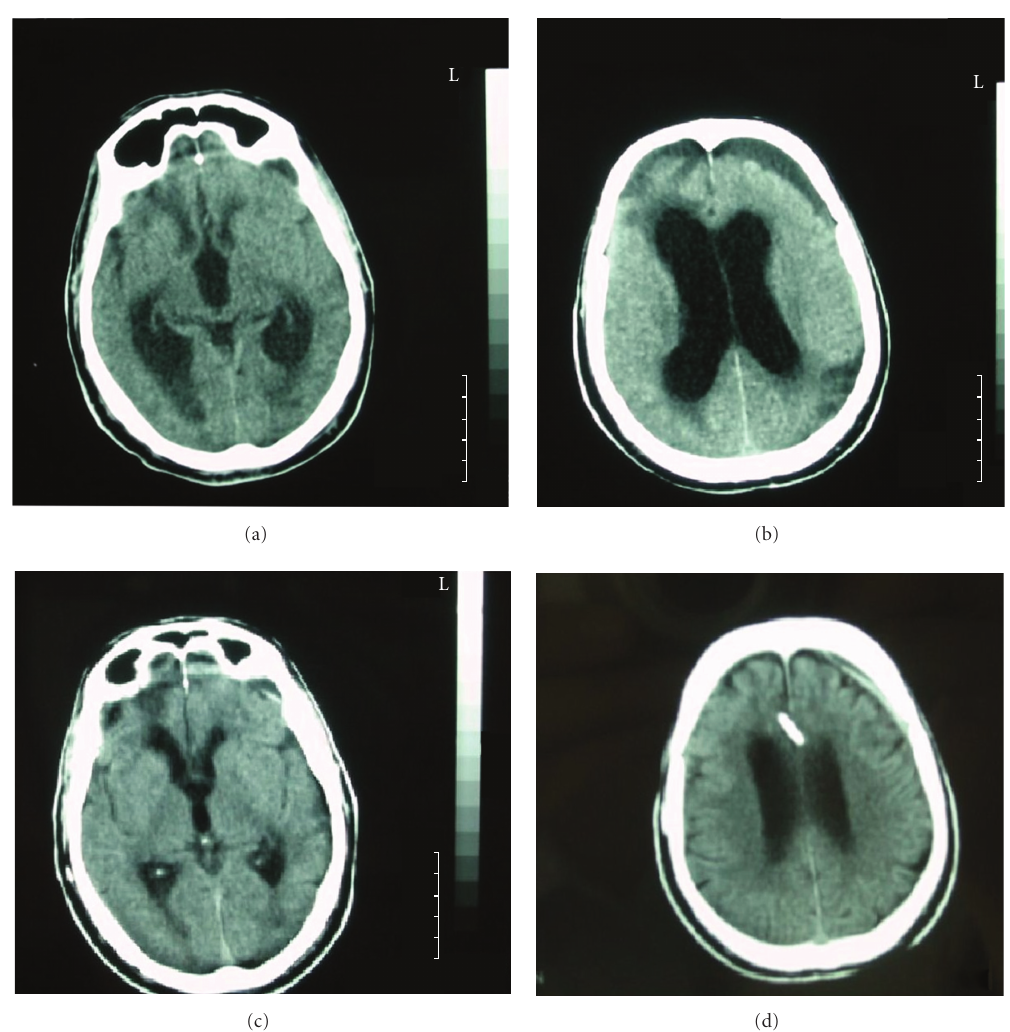
Figure 1: CT scan showing the left frontal subdural e ff usion associated with hydrocephalus (a) and (b) treated with V-P shunt.